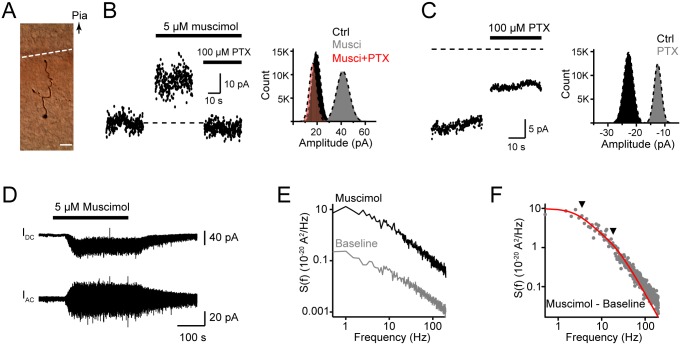
Properties of axonal GABAA receptors.A, DAB staining of an isolated axon bleb. The axon bleb was mechanically isolated from the main axon trunk before recording (see the Methods section). Arrow indicates the direction of the pia. Dashed line indicates the cut. Scale bar: 20 µm. B, Left, an example trace showing an increase in outward holding current after bath application of 5 µM muscimol (Vhold = 10 mV) and the blockade of this increase by 100 µM PTX. The dashed line indicates the baseline holding current. The mean values of Ihold for “Ctrl”, “Musci” and “Musci + PTX” group were 19.8, 41.4 and 16.9 pA, respectively. Right, histograms of the membrane currents shown on the left. The best-fit curves (dashed lines) were single Gaussian distributions. Axon blebs were recorded with patch pipettes filled with a low-Cl− ICS (7 mM [Cl−]i). C, Left, an example trace showing a decrease in inward holding current after bath application of 100 µM PTX (Vhold = –70 mV). The mean values of Ihold for “Ctrl” and “PTX” group were –22.8 and –12.5 pA, respectively. Right, histograms of the membrane currents shown on the left. Patch pipettes were filled with CsCl-based ICS (149 mM [Cl−]i). D, Current traces recorded in an isolated bleb. Vhold  = –60 mV, CsCl-based ICS was used. Top, the actual current response; bottom, current trace with DC Remove. E, Power spectral density plots of membrane current fluctuations in control and muscimol-treated conditions (same data as in D). F, Subtraction of the power spectral density in the control from that with muscimol treatment (same data from D and E). The red line was the fitting curve of double Lorentzian functions. Cut-off frequencies () of the two components (arrowheads) were 3.5 and 18.1 Hz.